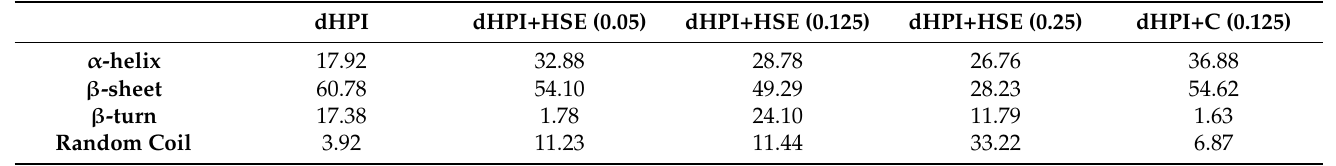
Table 4. Intensity values of major FTIR bands and secondary structure content (%) of dHPI–phenolic complexes from FTIR data.